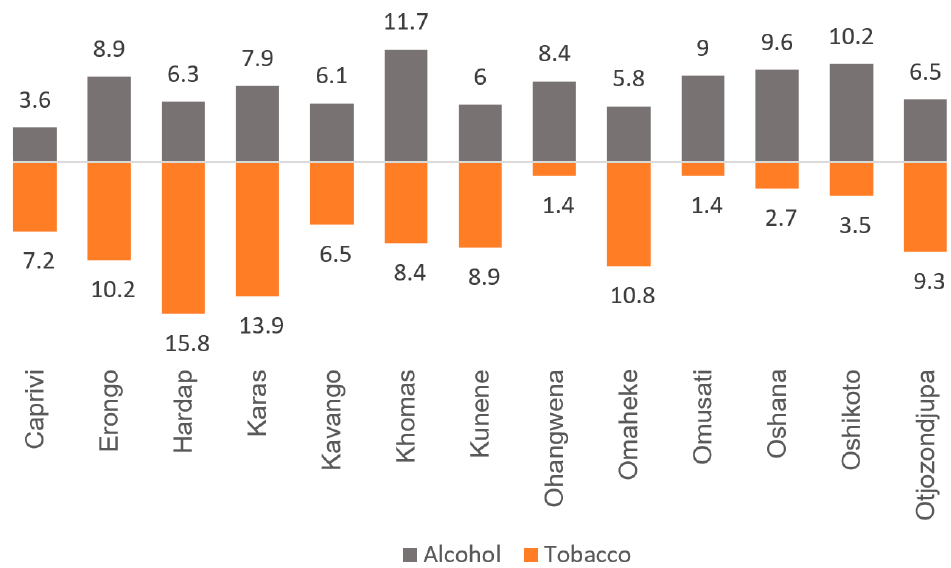
Figure 1. Regional prevalence of lifetime alcohol consumption and tobacco smoking in Namibia.